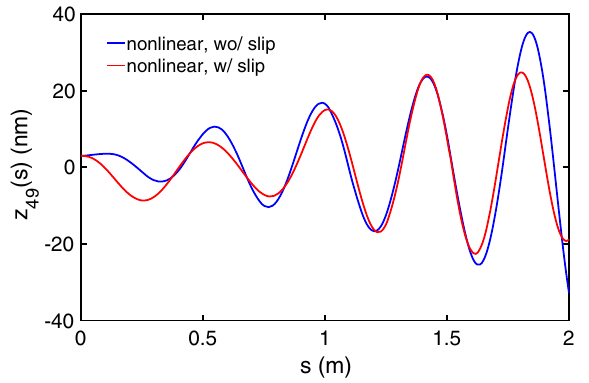
FIG. 5. Evolution of the most leading ( n ¼ 49 ) macroparticle along s for a bunch train with 50 microbunches. The blue and red curves are obtained from Eq. (17) without and with the slippage condition, respectively. The parameters are the same as those used in Fig.